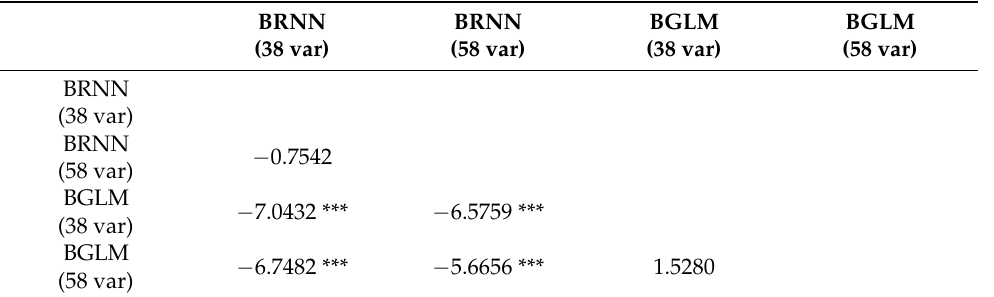
Table 4. MAE Comparison: Mean Comparison ( t -test, n = 340 companies * 9 iterations).